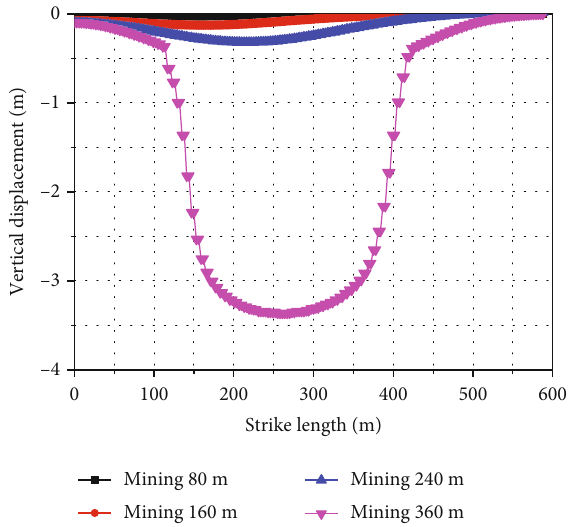
Figure 12: The vertical displacement in the THR middle part under di ff erent mining